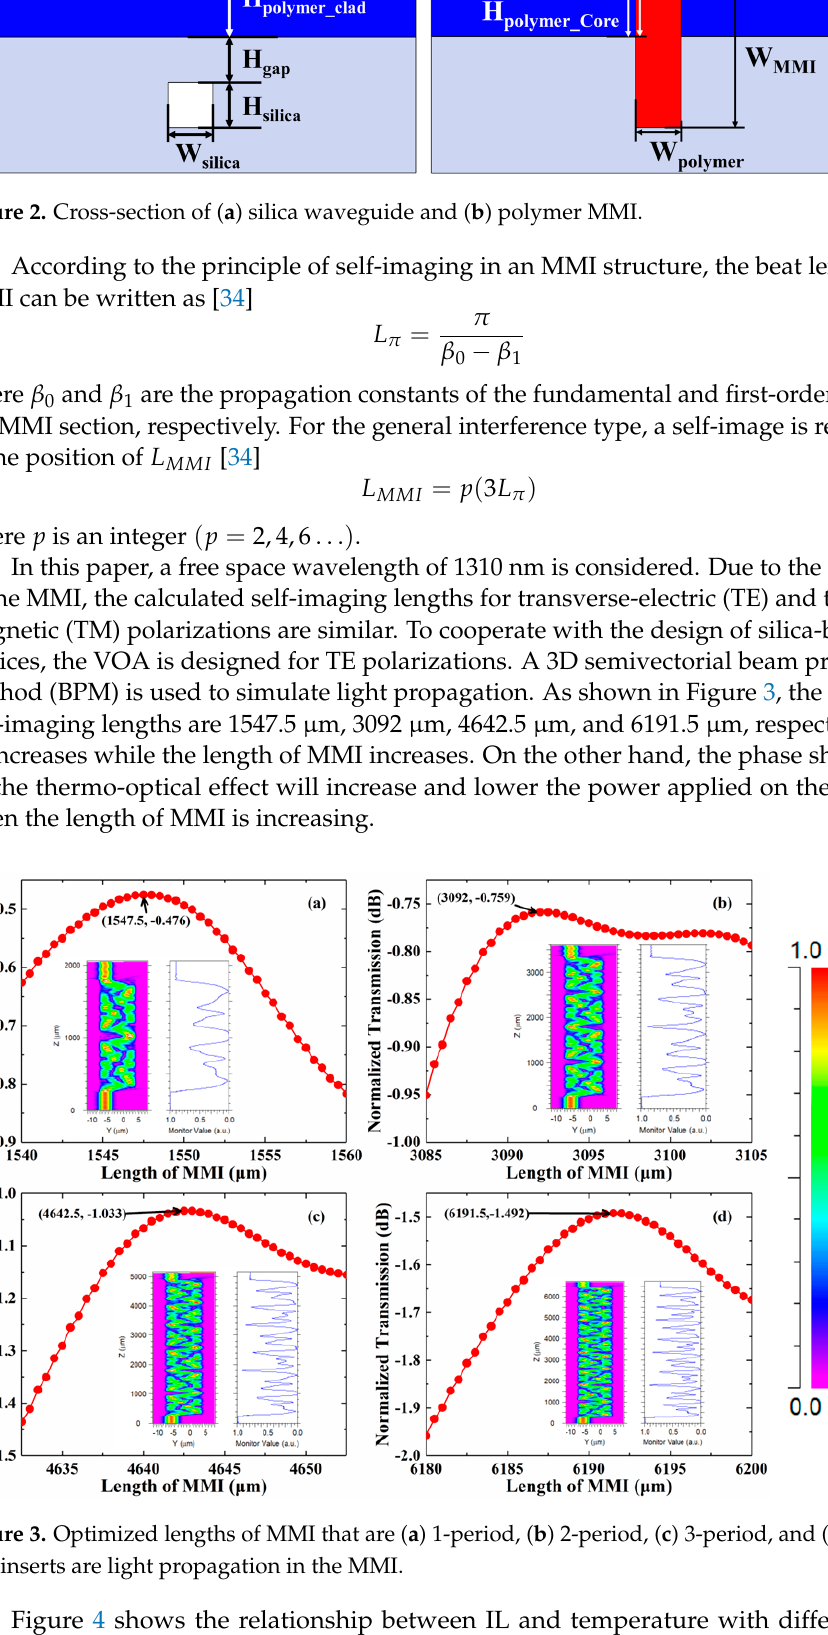
Figure 4. The relationship between IL and temperature change over ( a ) 1-period, ( b ) 2-period, ( c ) 3- -period, and ( d ) 4-period-long intervals.